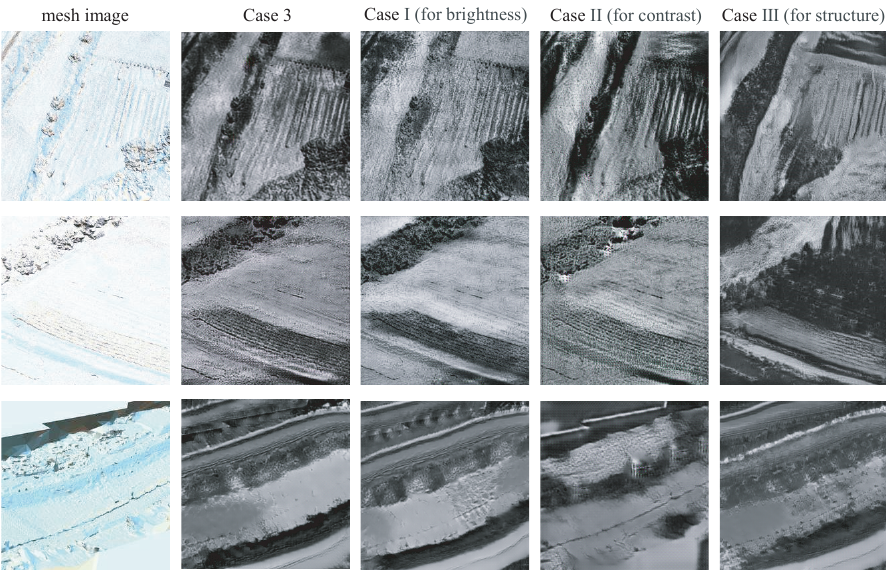
Figure 6. Image construction with respect to the variation of SSIM weight parameters.